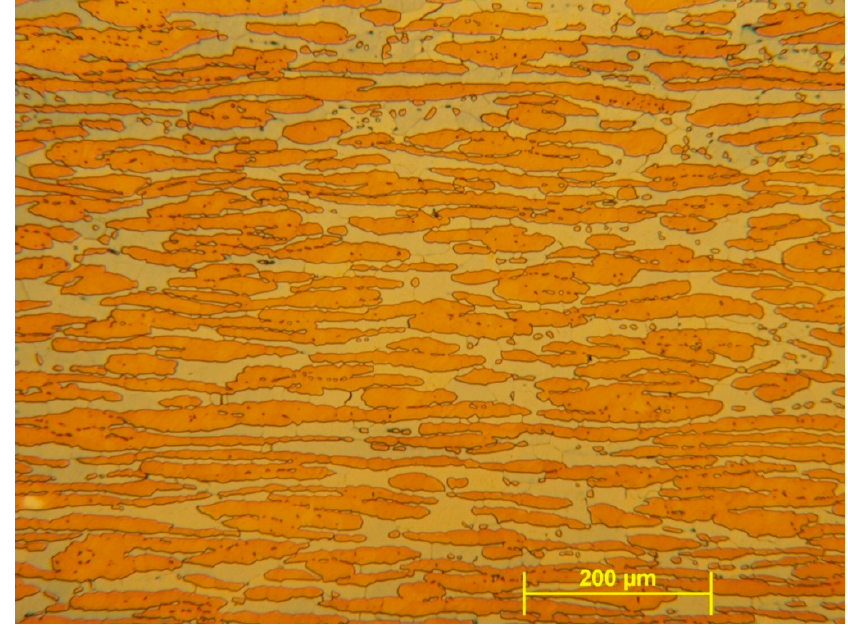
Figure 1. Optical micrograph of the untreated specimen.